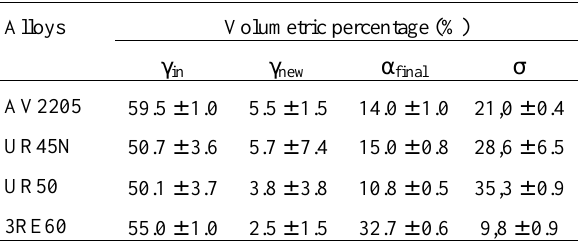
Table 3. The volumetric percentages of γ in , γ new , α final and σ phases in the alloys heat-treated for 1 h.